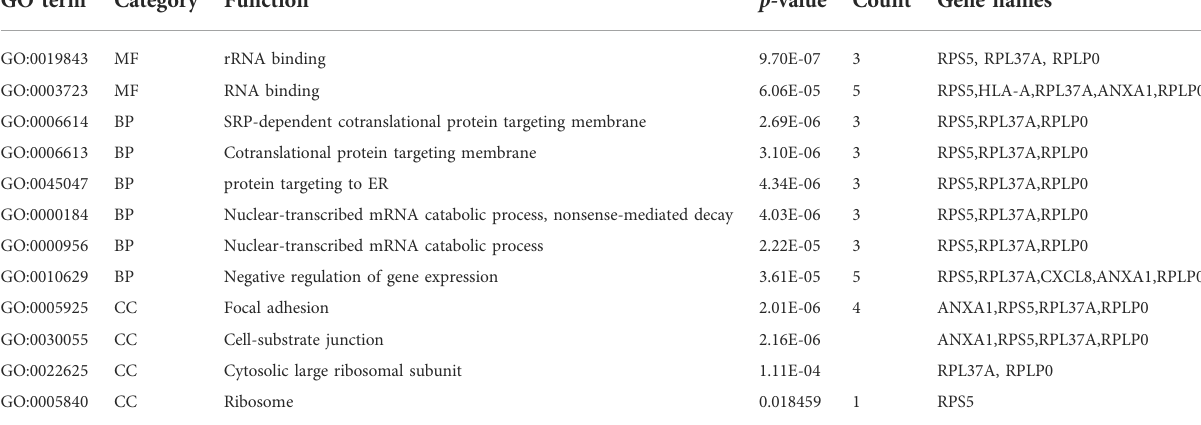
TABLE 3 The gene term enrichment analysis of hub genes associated with CKD.